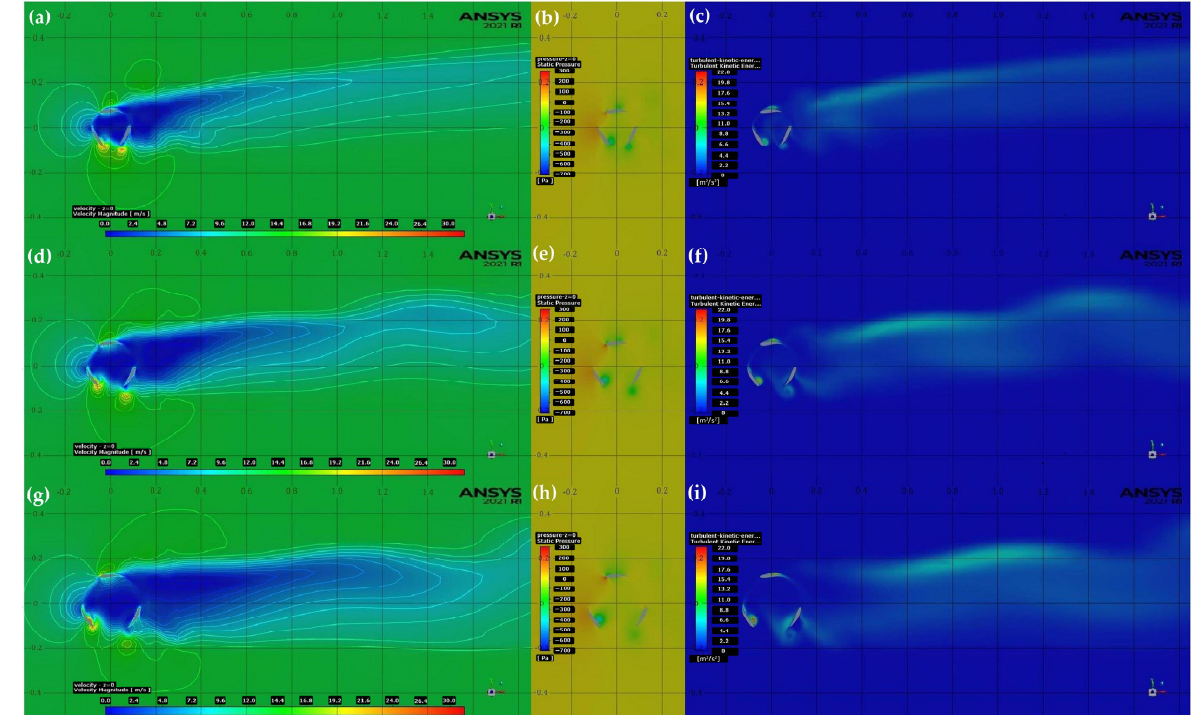
Figure 13. Contours at wind speed 14 m/s, rotational speed 98 rad/s for varied diameters: ( a ) Velocity at 0.15 m; ( b ) Pressure at 0.15 m; ( c ) TKE at 0.15 m; ( d ) Velocity at 0.20 m; ( e ) Pressure at 0.20 m; ( f ) TKE at 0.20 m; ( g ) Velocity at 0.25 m; ( h ) Pressure at 0.25 m; ( i ) TKE at 0.25 m.